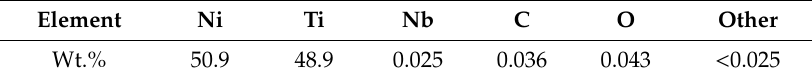
Table 2. Elemental composition of the workpiece material.